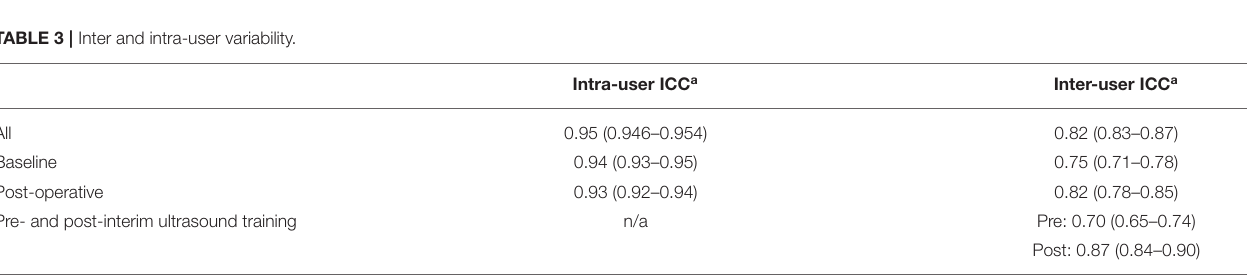
TABLE 3 | Inter and intra-user